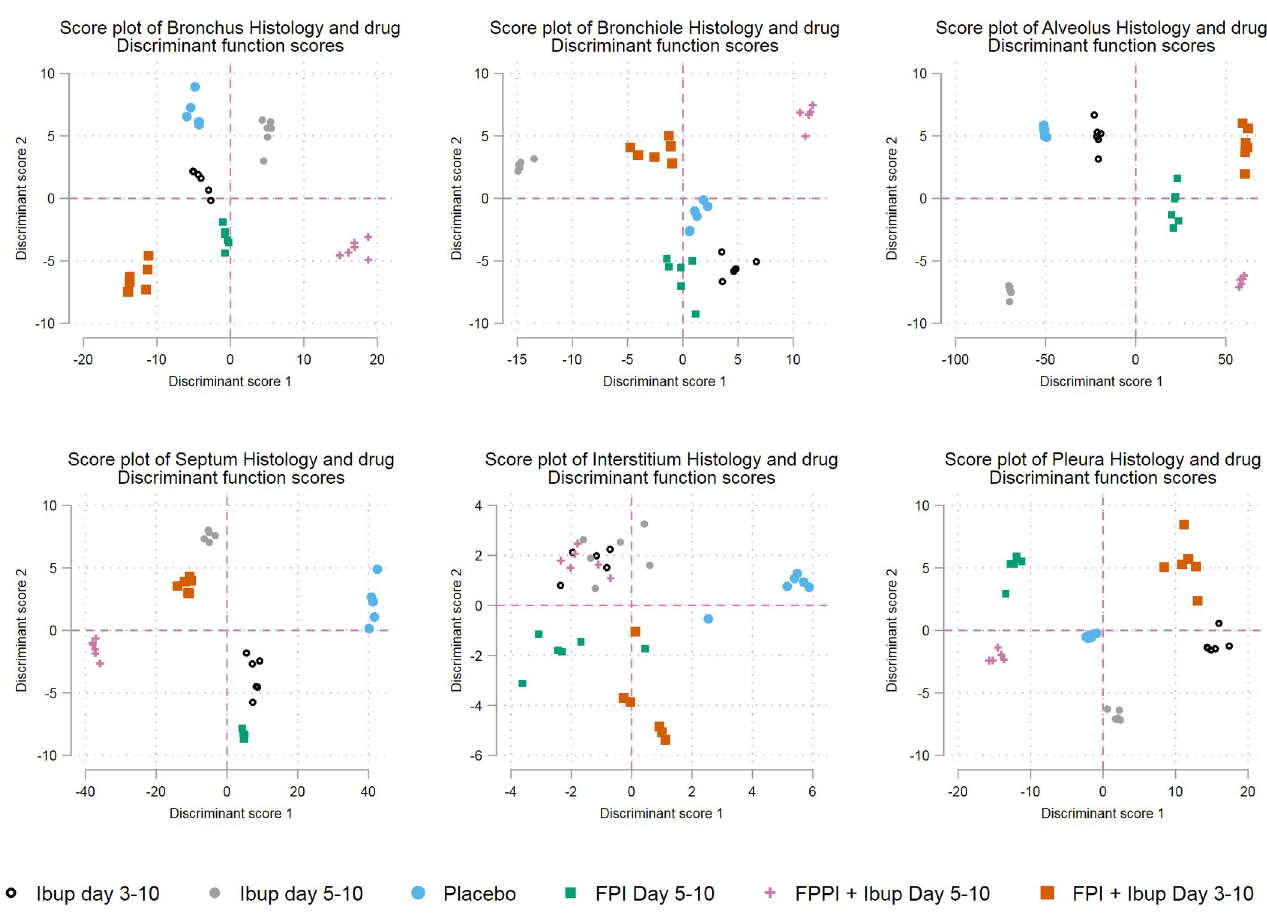
Fig 8. Canonical discriminant analysis for histological findings at the structural level. FPI; fusion protein inhibitor, Ibup; Ibuprofen.